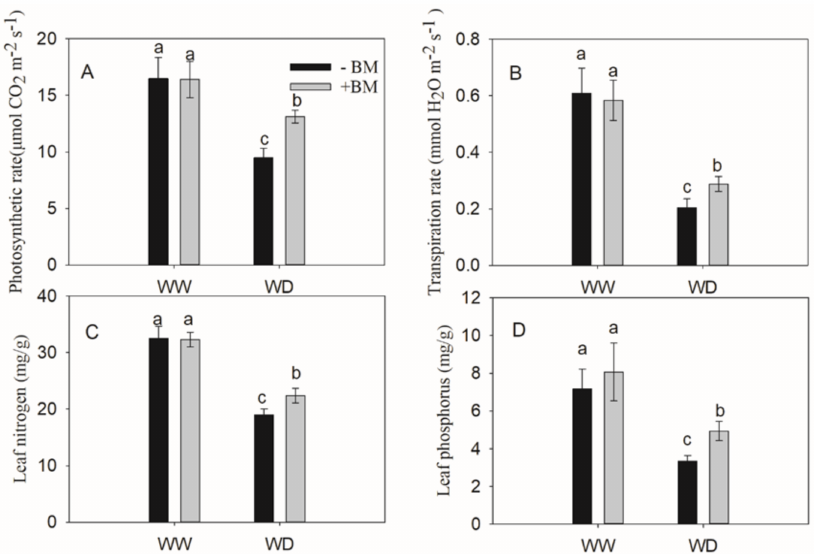
Figure 6. Effect of BM application on leaf photosynthetic rate ( A ), transpiration rate ( B ), nitrogen ( C ) and phosphorus ( D ) of ryegrass under two water status. WW and WD showed the different soil water contents. The different letters indicate significant difference ( p < 0.05).